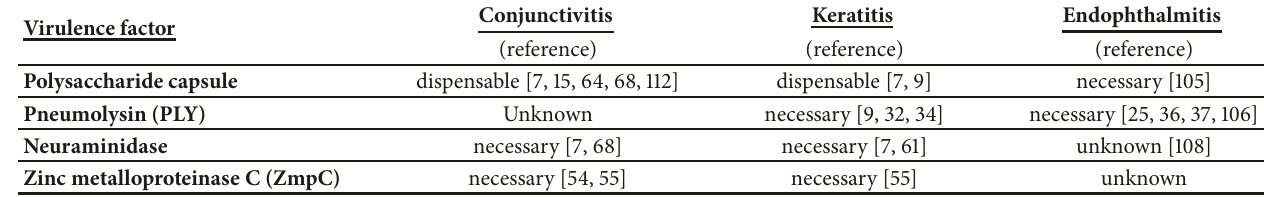
Table 1: Virulence factor requirement during different ocular infectious